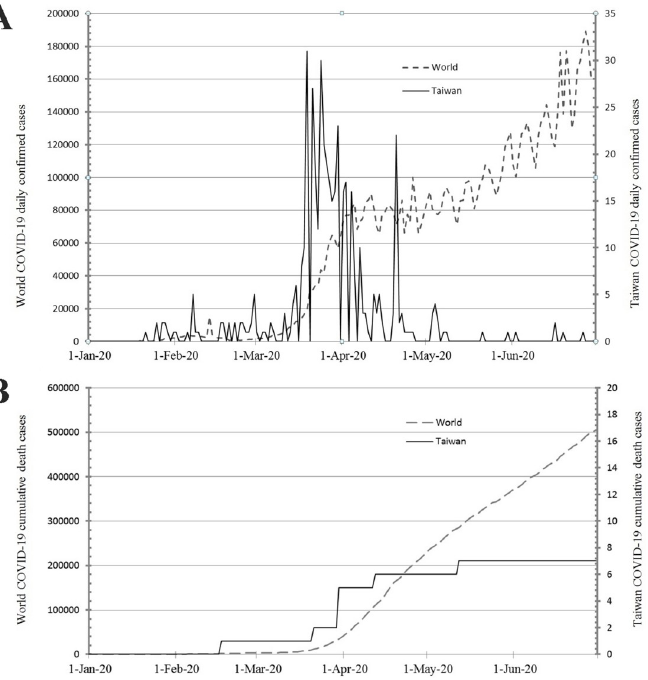
Fig 1. A: Daily incidence of coronavirus disease 2019 (COVID-19) globally (dotted line, left scale) and in Taiwan (solid line, right scale). Note the surge in Taiwan began on March 20, 2020, and ended on April 7, 2020 with another short surge on April 20, 2020, while the surge globally began on March 25, 2020, and has still not reached a peak. B: Cumulative deaths due to COVID-19 globally (dotted line, left scale) and in Taiwan (solid line, right scale). Cumulative deaths in Taiwan plateaued after May 12, 2020, while cumulative deaths were still increasing globally [15]. 1-Jan-20 indicates January 1, 2020.